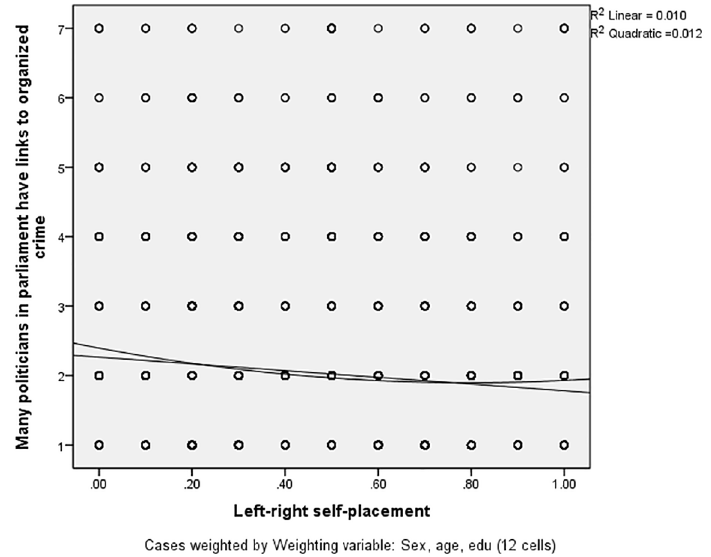
Figure 5. Linear and quadratic relationship between political ideology and belief that politicians have links to organized